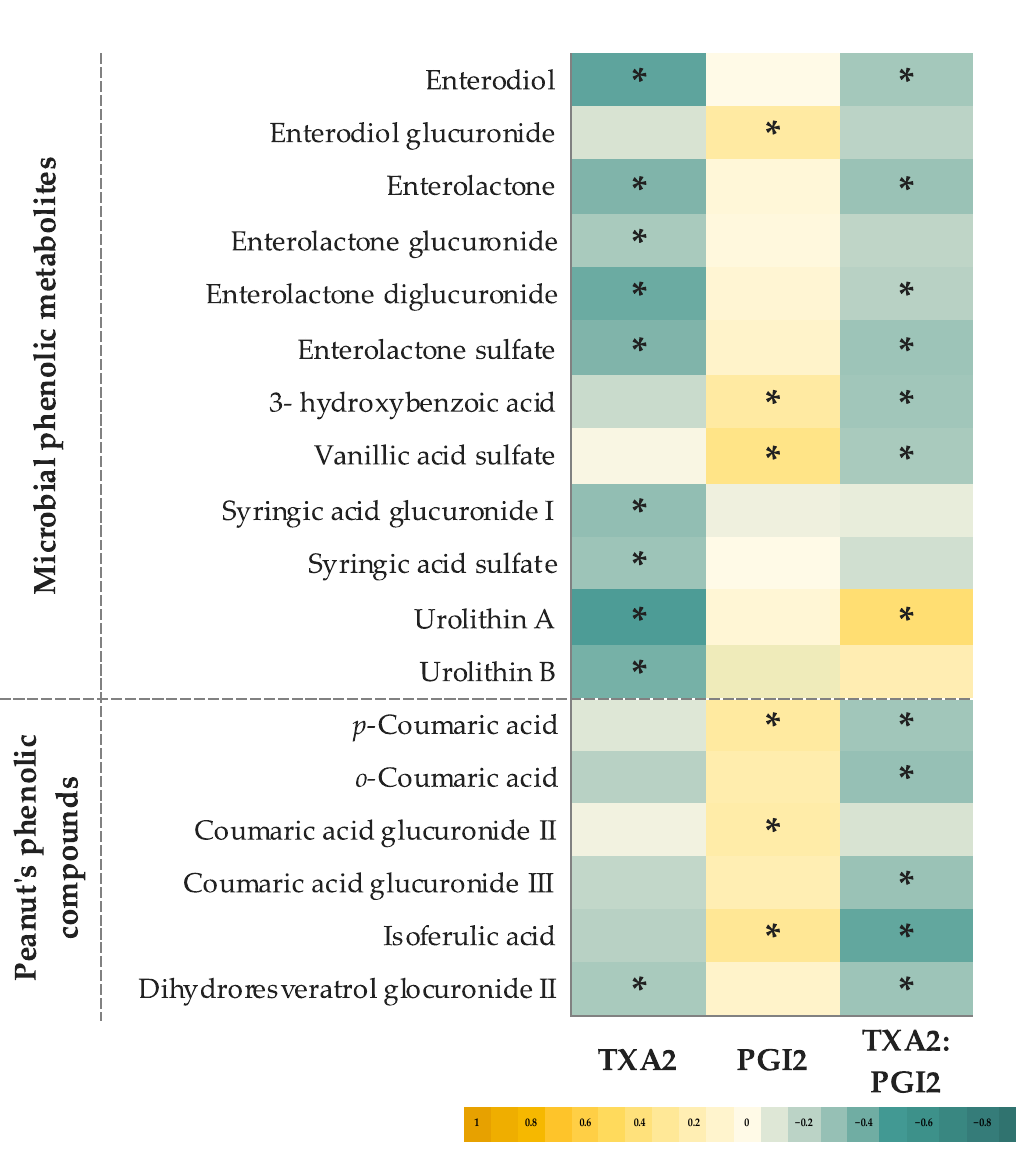
Figure 1. Heatmap of correlations between urinary phenolic metabolites and eicosanoids. The value of the correlation coefficient (r) ranging from − 1 to 1 is expressed in green and yellow, respectively, in the bar bellow. *: refers to significant Spearman correlations p < 0.005.